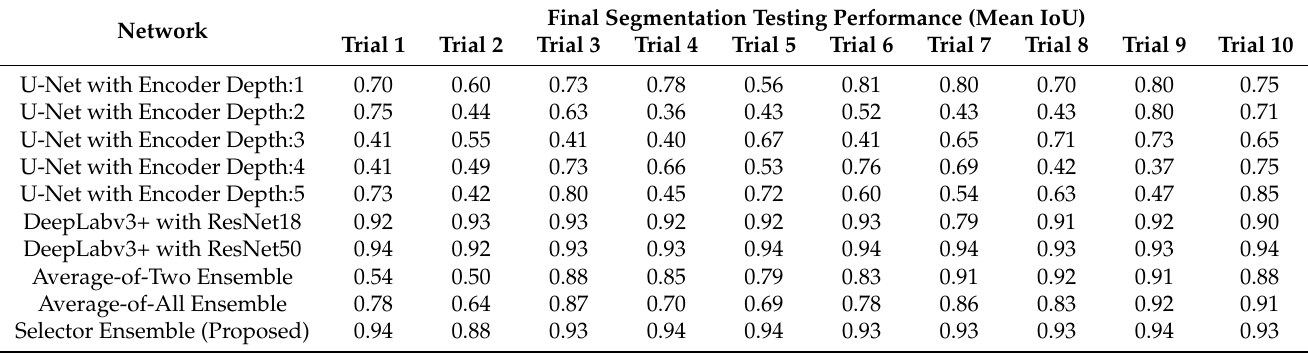
Table A1. Mean IoU values of the final lung segmentations obtained during testing with the ’selected’ cases out of 138 chest radiographs from the MC